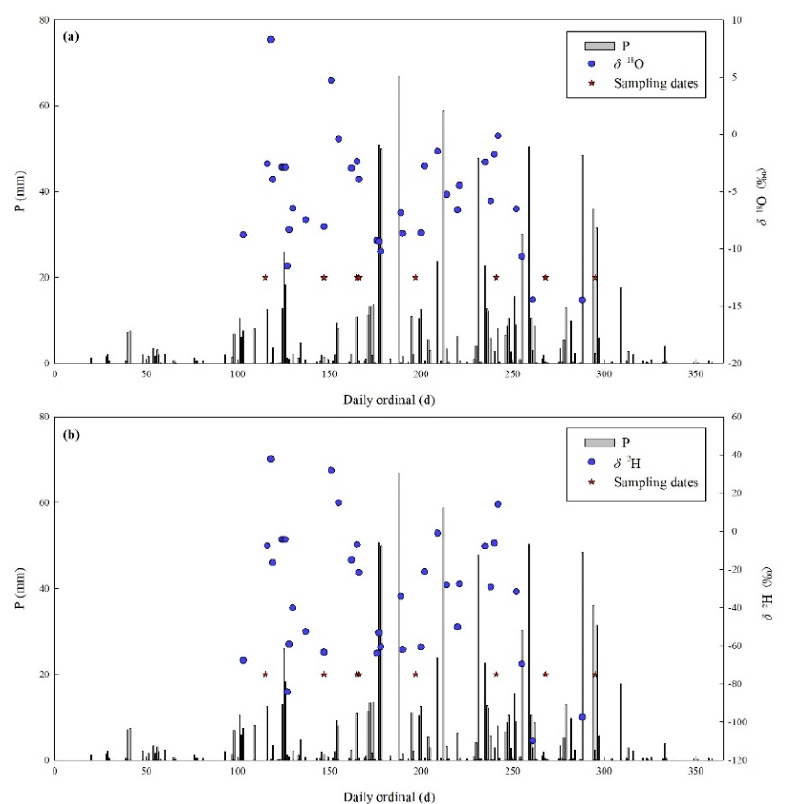
Figure 2. The precipitation and isotopic composition of rainwater in 2019. The blue dots in ( a ) and ( b ) are δ 18 O and δ 2 H, respectively; the red stars represent sampling dates during the growing season.